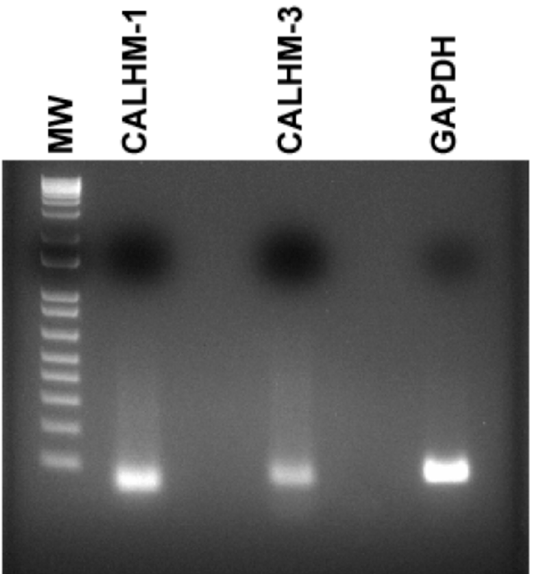
Figure 3. Detection of CALHM-1 and CALHM-3 in HBO cells. In HBO cell lysates, using CALHM1 and CALHM3 Taqman primer assay mix, RT-PCR yielded single bands of 55 bp and 64 bp, respectively. GAPDH was used as an endogenous control. Molecular weight (MW) DNA ladder bands correspond to 100–1 Kb (bottom to top).